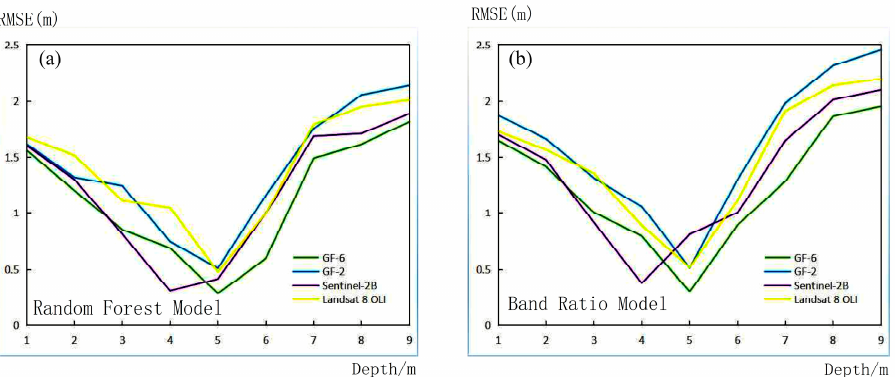
Figure 9. RMSE by different methods, different images, and different water depth range: ( a ) Random Forest Model; ( b ) Band Ratio Model.